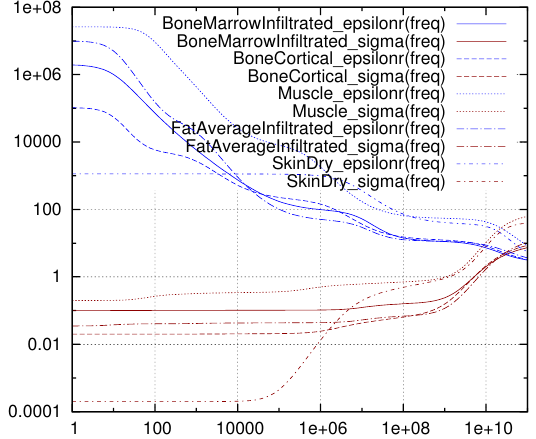
Fig. 7: Electrical properties for the tissues used in this tutorial [8]. The properties are electrical conductivity ( σ ) plotted in red and relative permittivity ( ε r ) plotted in blue.